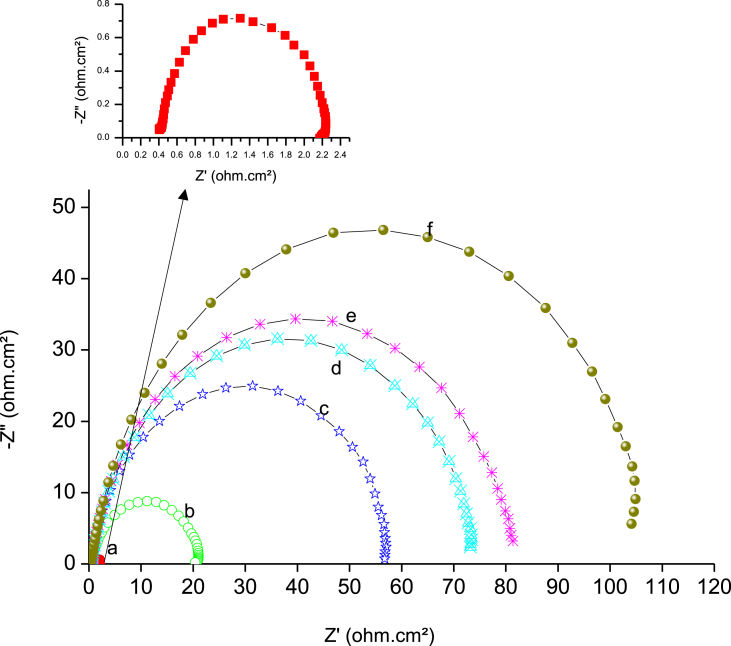
Nyquist plots for a) mild steel in 2 M H2SO4, and b) 0.05, c) 0.10, d) 0.25, e) 0.50, and f) 1 mM of BQYP molecule at 298 °K.